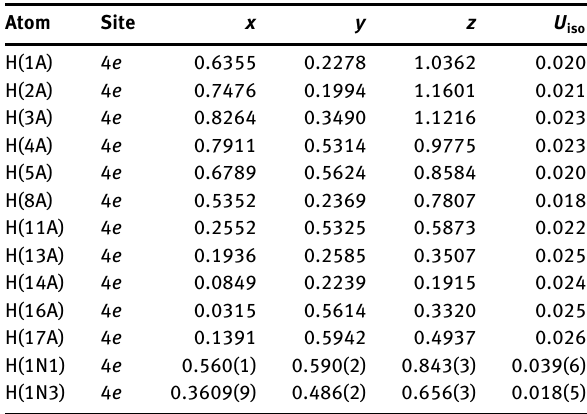
Table 2: Fractional atomic coordinates and isotropic or equivalent isotropic displacement parameters (Å 2